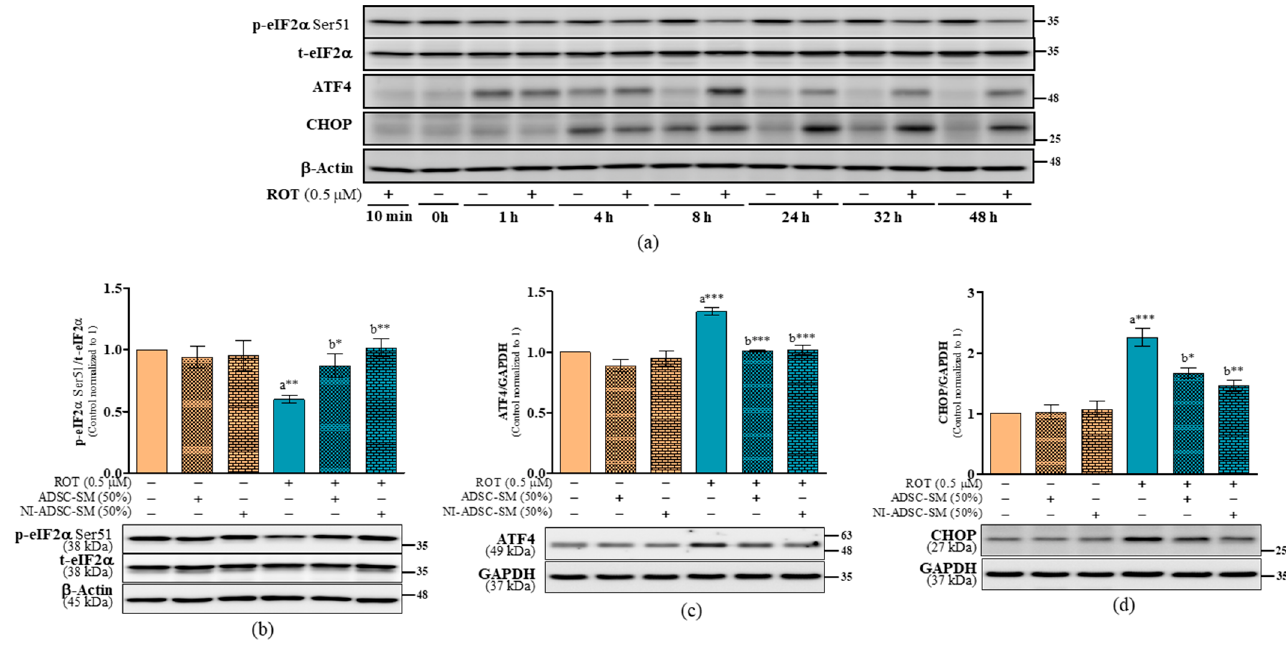
Figure 10. Effects of the NI-ADSC-SM on eIF2 α , ATF4, and CHOP expression. Cells treated with or without ROT (0.5 µ M) at different timepoints were assessed for above protein expressions by Western blotting ( a ). Cells were incubated in the presence of ROT (0.5 μ M) or DMSO for 48 h alone or with the ADSC-SM or NI-ADSC-SM (each diluted by 50%) during the last 24 h. The levels of p-eIF2 α Ser51/t-eIF2 α ( b ), ATF4/GAPDH ( c ), and CHOP/GAPDH ( d ) protein expression were assessed by Western blotting. Data are shown as the means (bars) and SEM (error bars) of three independent cell culture experiments. Statistical analysis was performed using one-way ANOVA with Tukey’s post-test. Statistical comparisons: a—compared with control; b—compared with ROT; * p < 0.05, ** p < 0.01, and *** p < 0.001. p-, phosphorylated; t-, total.